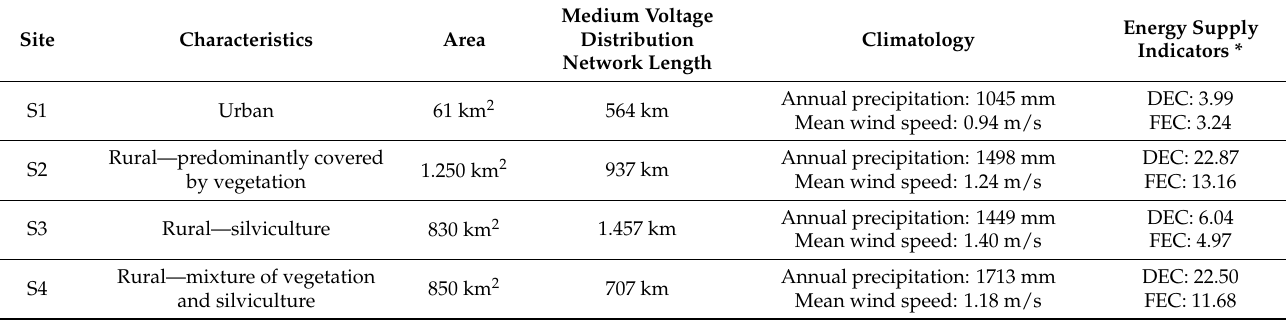
Table 1. Summary information about the four sites selected in this study.